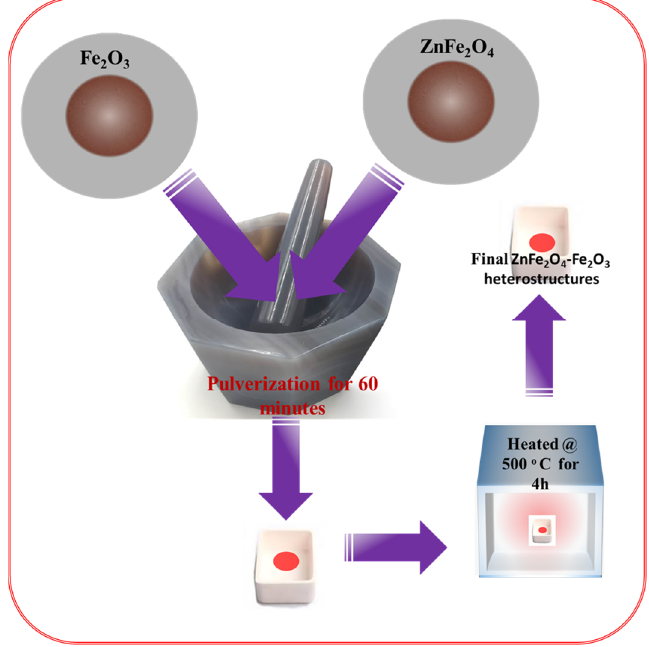
Figure 1. The schematic of the preparation of the composite structure.